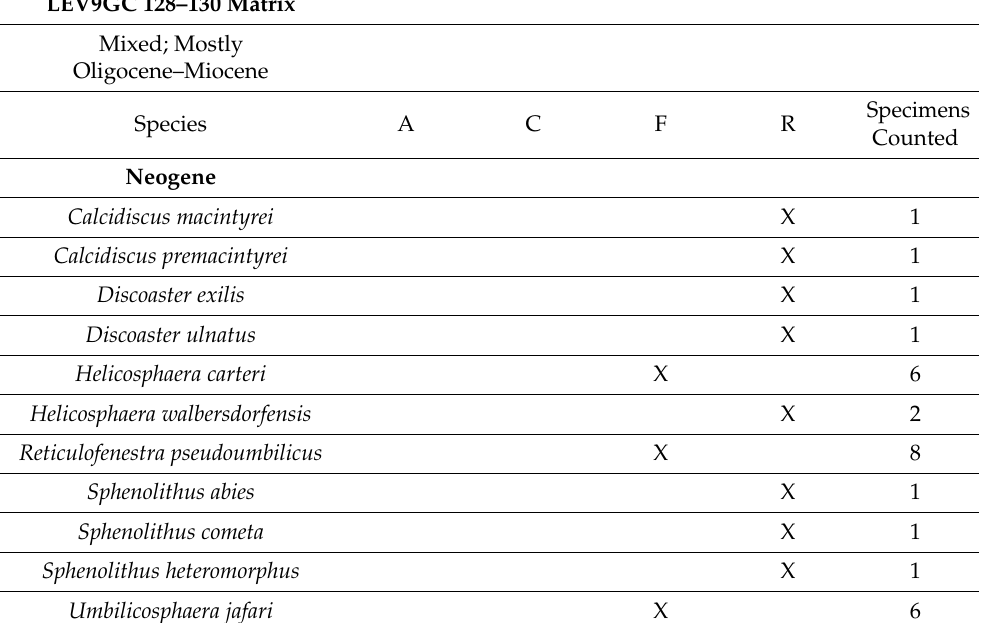
Table A44. Leipzig